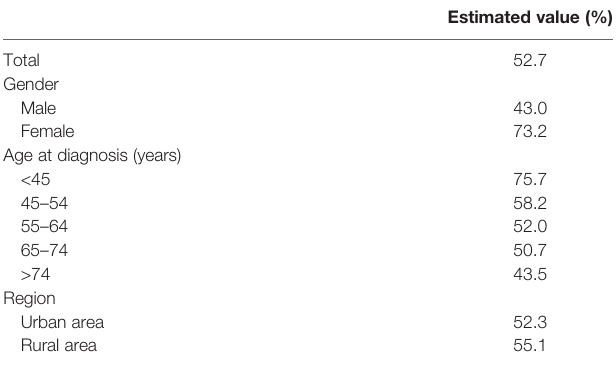
TABLE 4 | Prediction of the survival of lung cancer patients in four cancer registries of Taizhou City from 2019 to